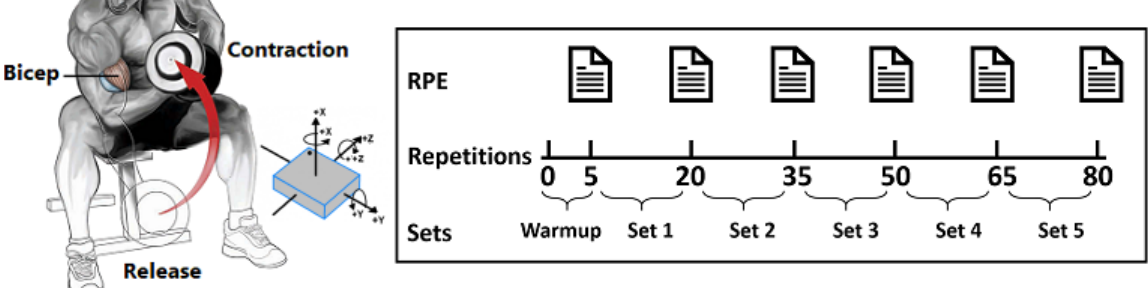
Figure 1. Visualization of data acquisition sessions of biceps concentration curl exercise. Rating of Perceived Exertion (RPE).